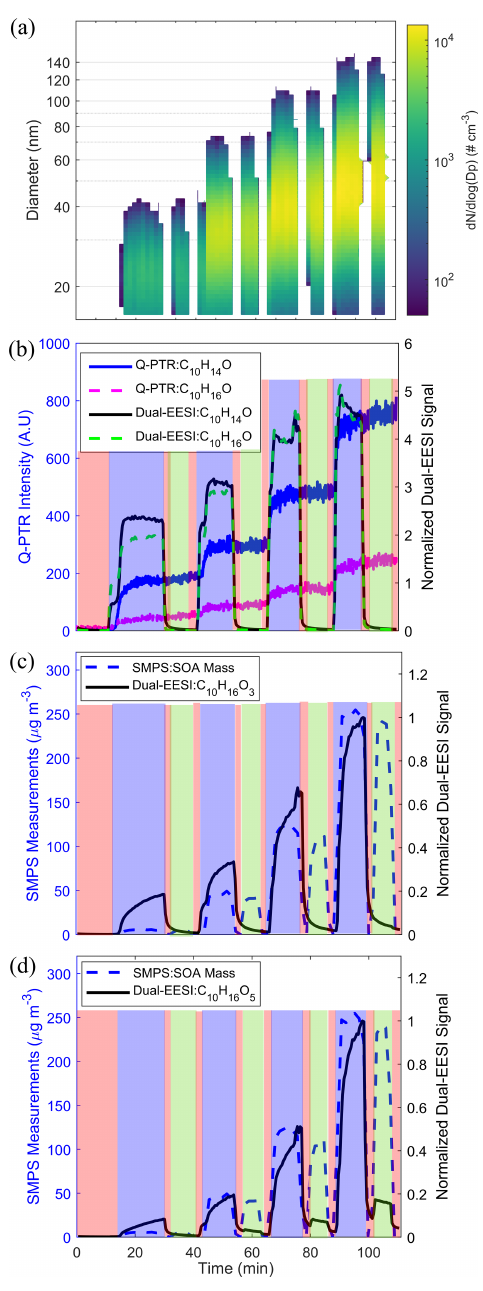
Figure 4. (a) SMPS size distribution for four experimental stages, each with different SOA mass concentrations (regions where d N/ dlog (D p ) < 50cm − 3 are replaced by blank space). (b) Comparison of the Dual-EESI and Q-PTR measurements for C 10 H 14 , 16 O. Normalized Dual-EESI signal of (c) C 10 H 16 O 3 and (d) C 10 H 16 O 5 for increasing SOA mass concentration. Each sam- pling cycle consists of 10–15min of TP (blue), 5min of FP 1 (red), 10min of PP (green) and 5min of FP 2 (red) measurements. Note that the switching of the sampling channel for FP and PP only started when the signals of C 10 H 16 O 3 − 5 reached a steady state in the TP. Thus, the sampling time of the first TP phase of each cycle varied for these four